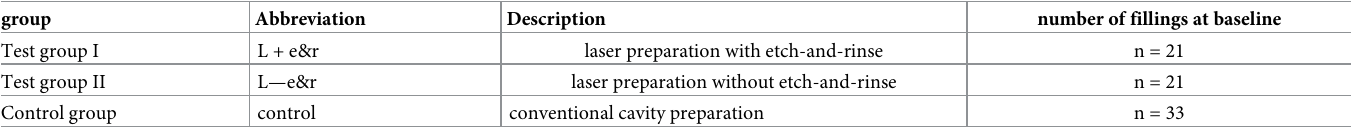
Table 1. Experimental group